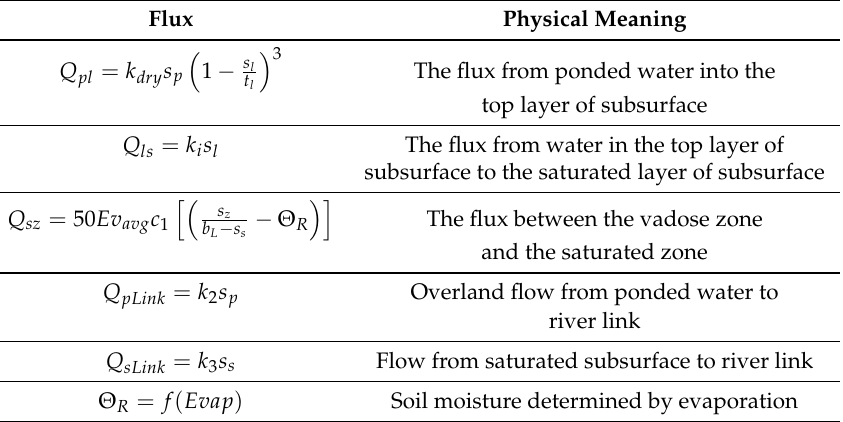
Table 1. Flux formulas and descriptions for the ODE system (8).